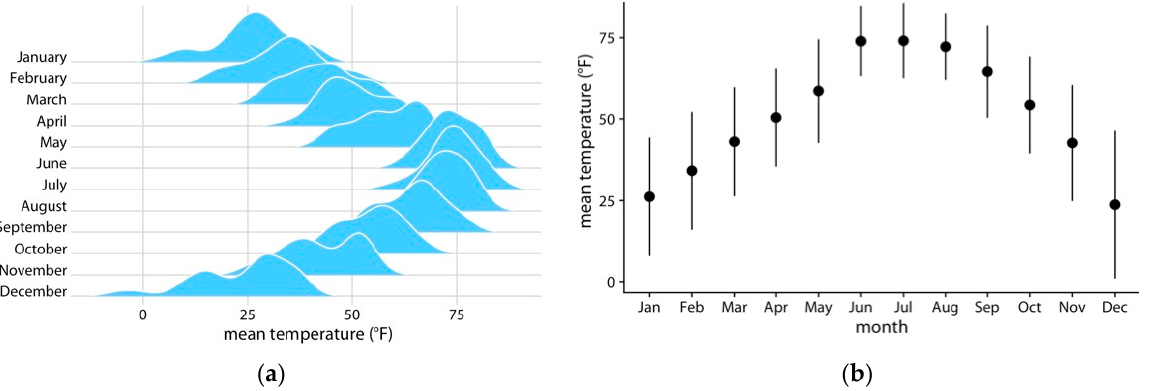
Figure 4. In pane ( a ), the representation of uncertainty, or rather our knowledge, in the form of probability density allows its informative use in decision-making schemes. In ( b ), where the expected value surrounded by the limits of ± 1 standard errors are plotted, only the information on the dispersion of the observations is provided, which gives a measure of the uncertainty, but does not allow us to use it in the decision-making phase.